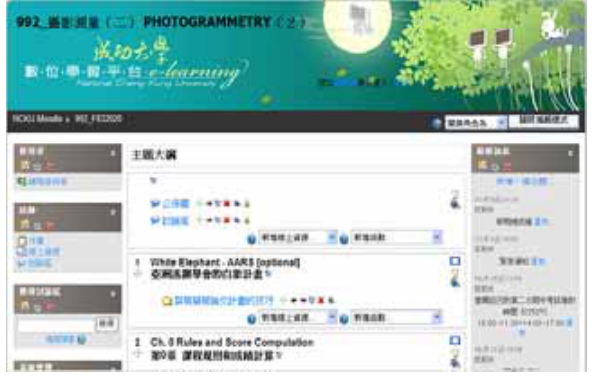
Figure 6. Editing Functions of NCKU Moodle